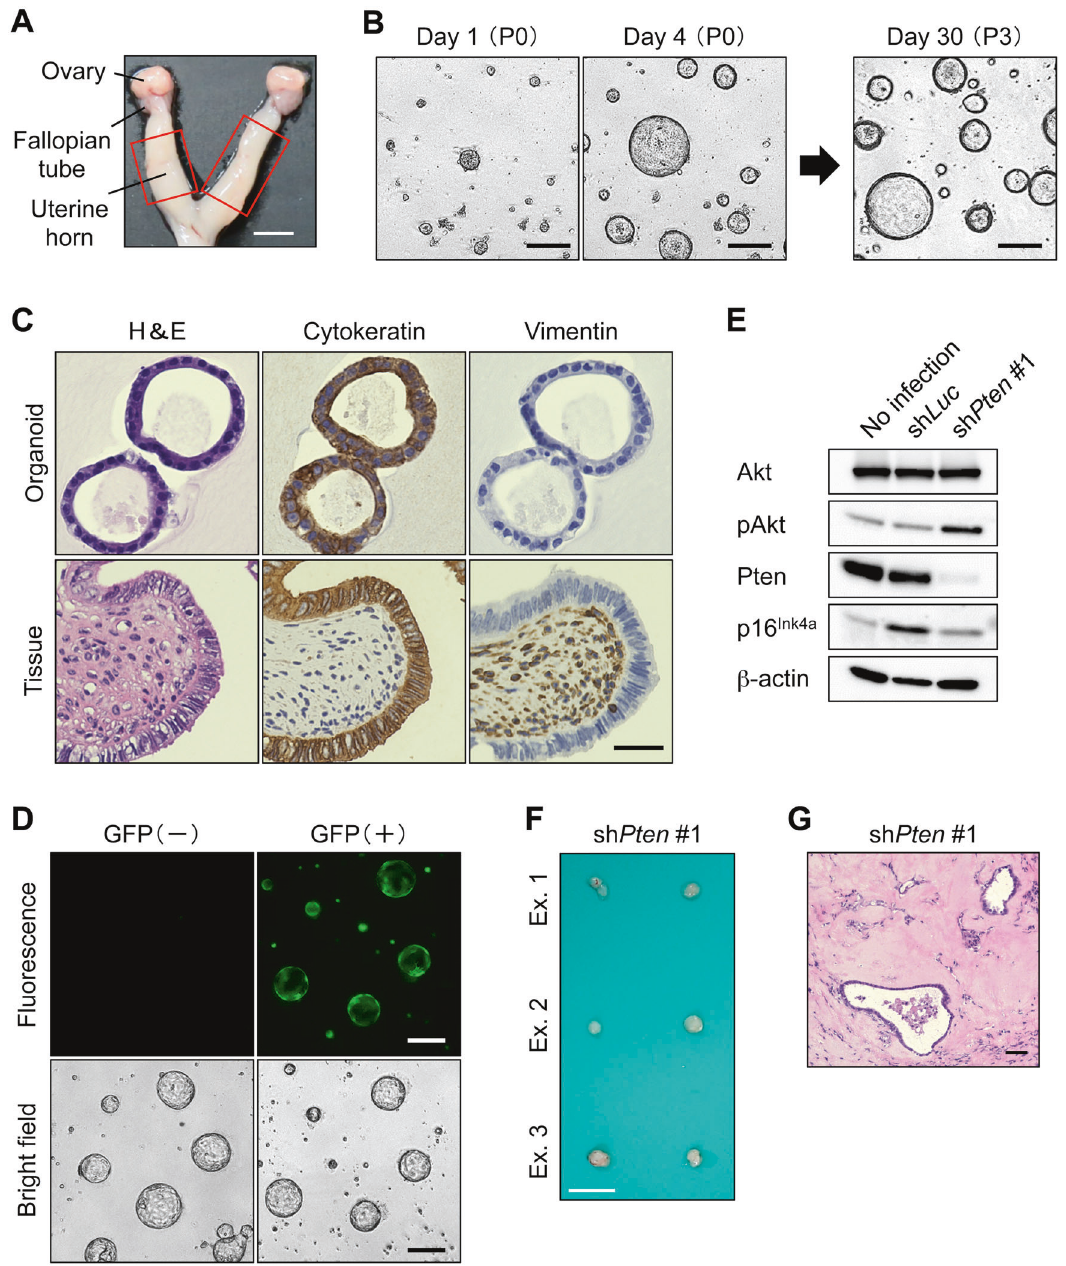
images of primary (P0) cells and after 3 passages (P3) are shown. Scale bar, 200 μ m. C Immunohistochemical (IHC) staining. Upper panel , organoids. Lower panel , uterine tissue. Immunostaining results of serial sections with antibodies against cytokeratin or vimentin are